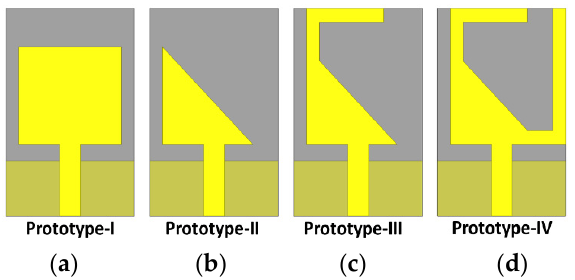
Figure 17. Evolution steps of antenna presented in Figure 17. Different geometrical shapes ( a – d ).